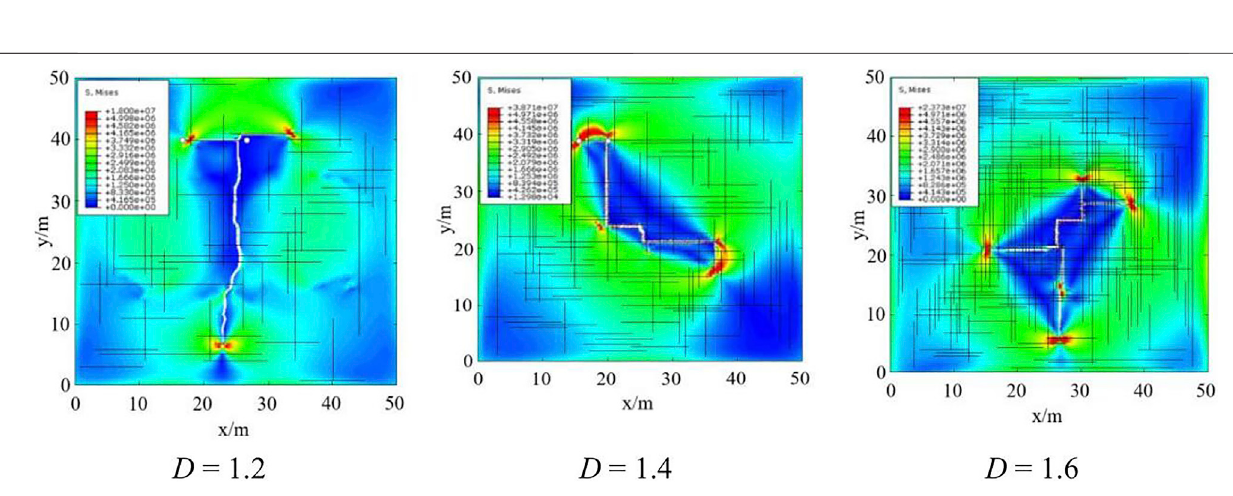
Frontiers in Earth Science |